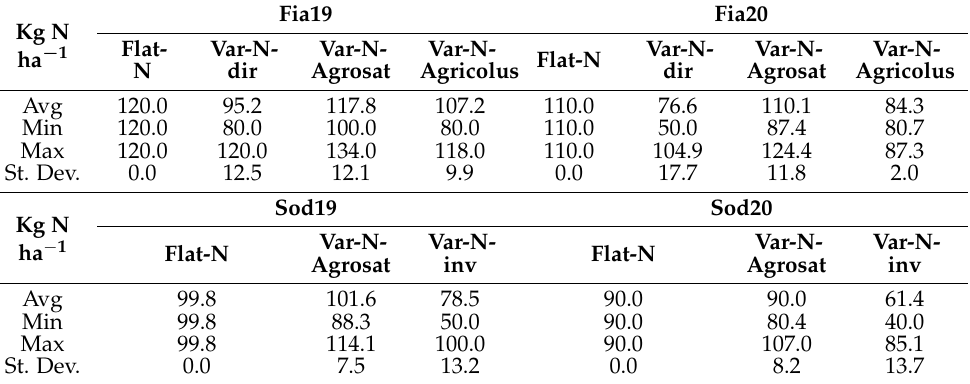
Table 5. Main statistics of fertilization treatment doses (2nd application) for all experimental fields. Fia19 Fia20 Kg N Var-N- Var-N- Var-N- Flat- ha − 1 dir Agrosat Agricolus N